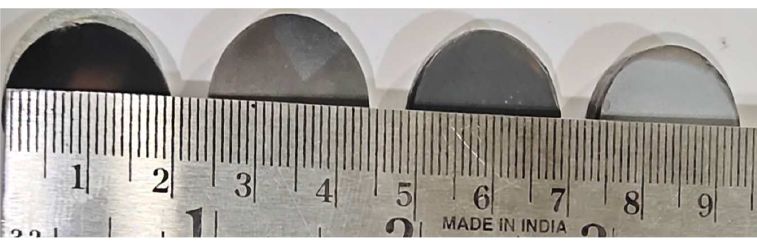
Figure 1. Manufactured composite samples.